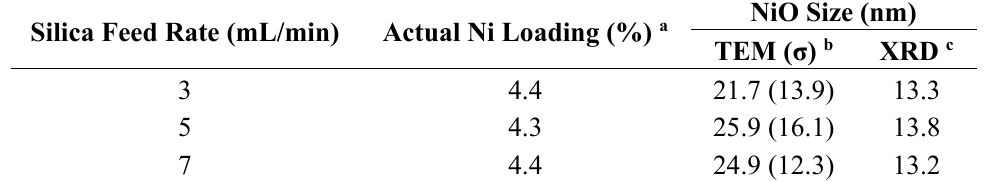
Table 1. Summary of Ni properties of Ni-SiO 2 with silica being prepared by FSP at varying feed rates.